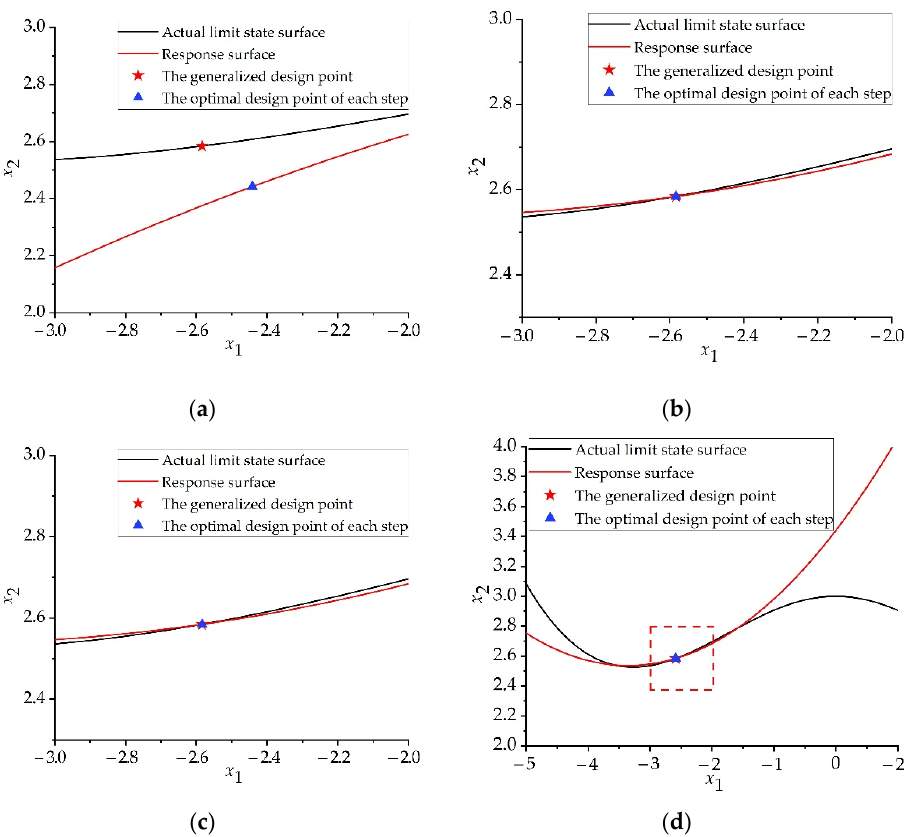
Table 2. Result comparison using different methods for Example 1.